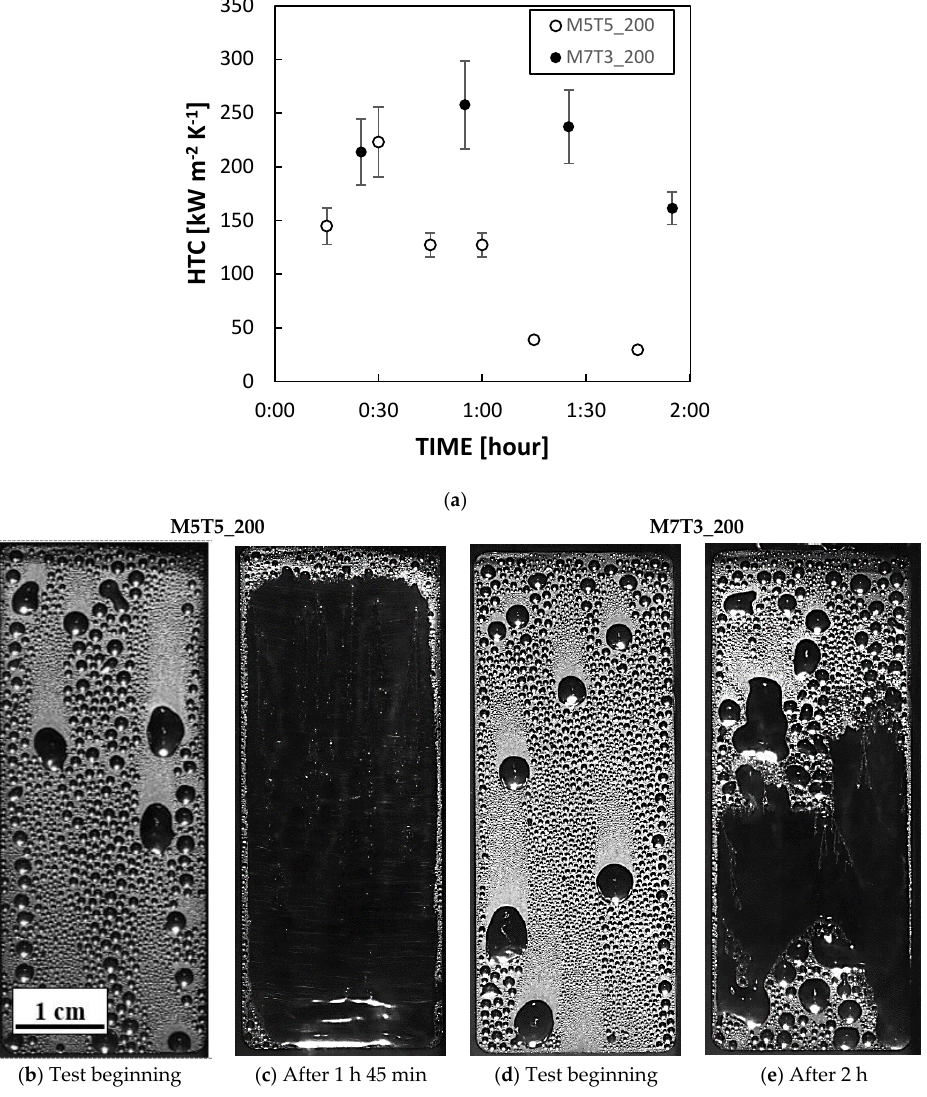
Figure 5. ( a ) Heat transfer coefficient (HTC) of M5T5_200 and M7T3_200 samples. ( b – e ) Images recorded at the beginning and at the end of the condensation test for M5T5_200 and M7T3_200, respectively. All data were recorded at constant saturation temperature (105 °C), constant vapor velocity (2.6 m s −1 ) and constant heat flux (400 kW m −2 ).